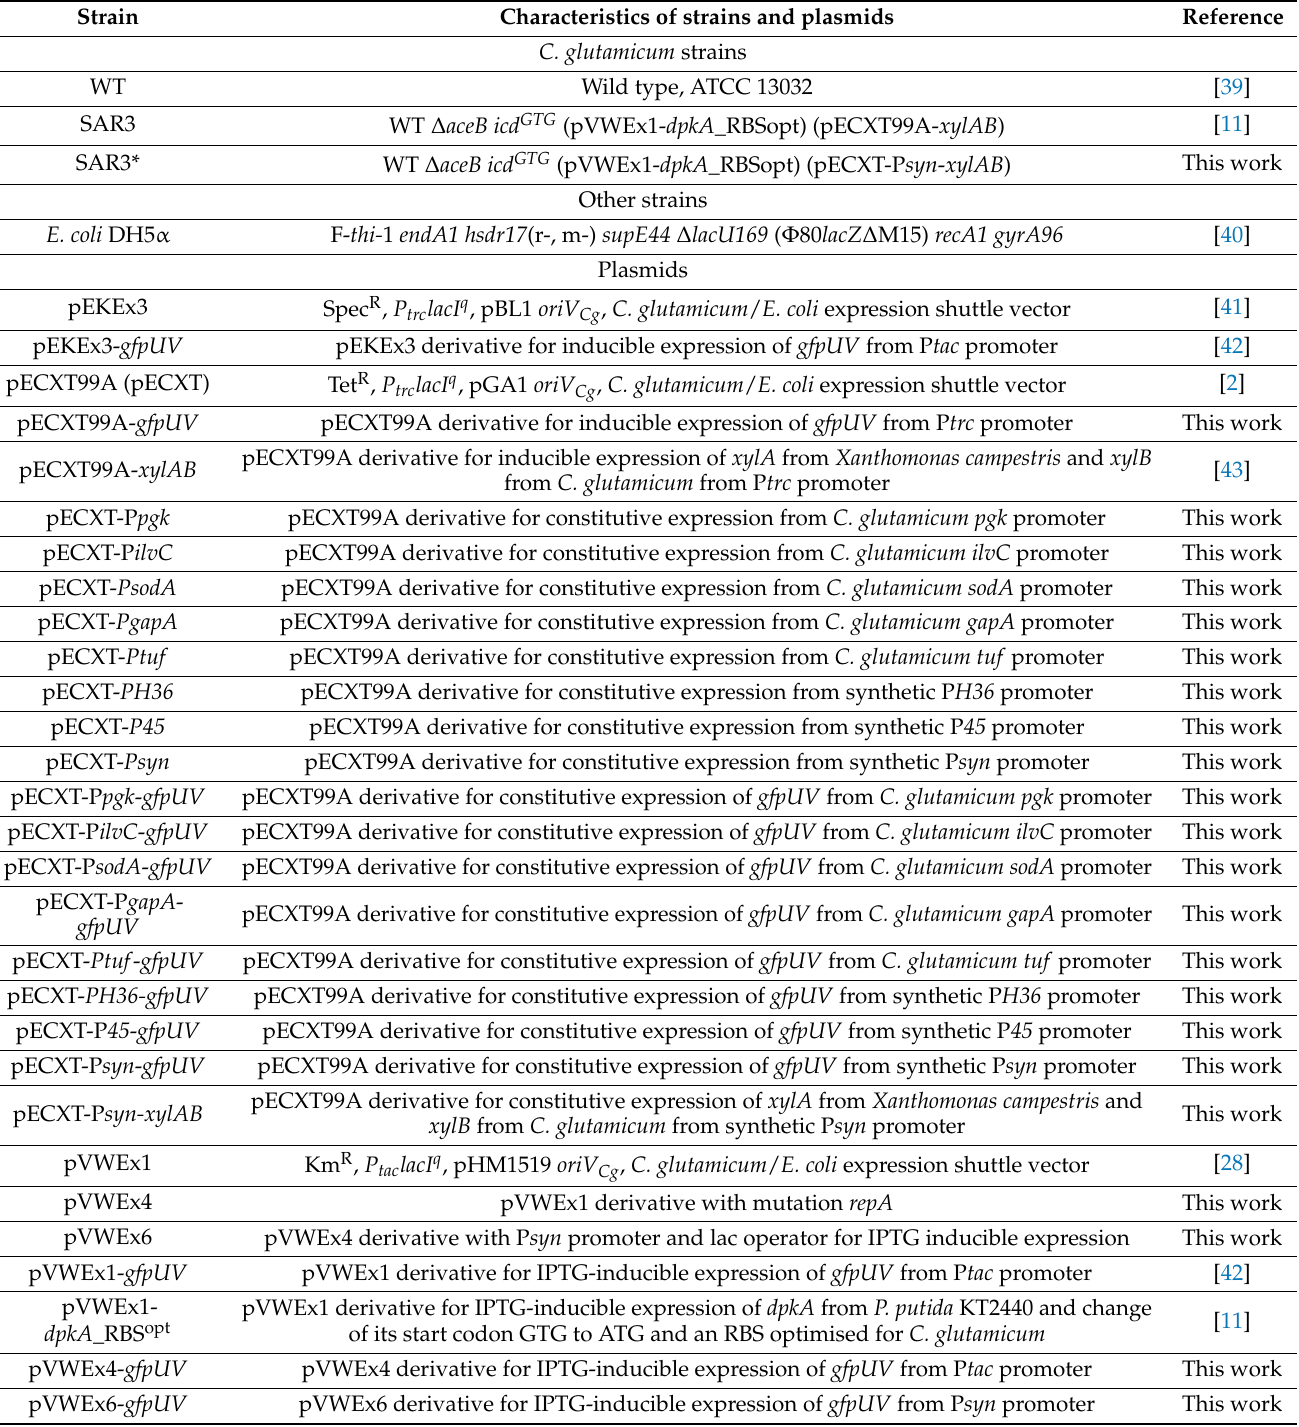
Table 1. Strains and plasmids used in this